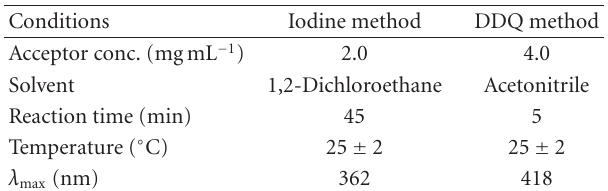
Table 1: Optimum conditions for the charge-transfer reaction of OMZ with both iodine and DDQ